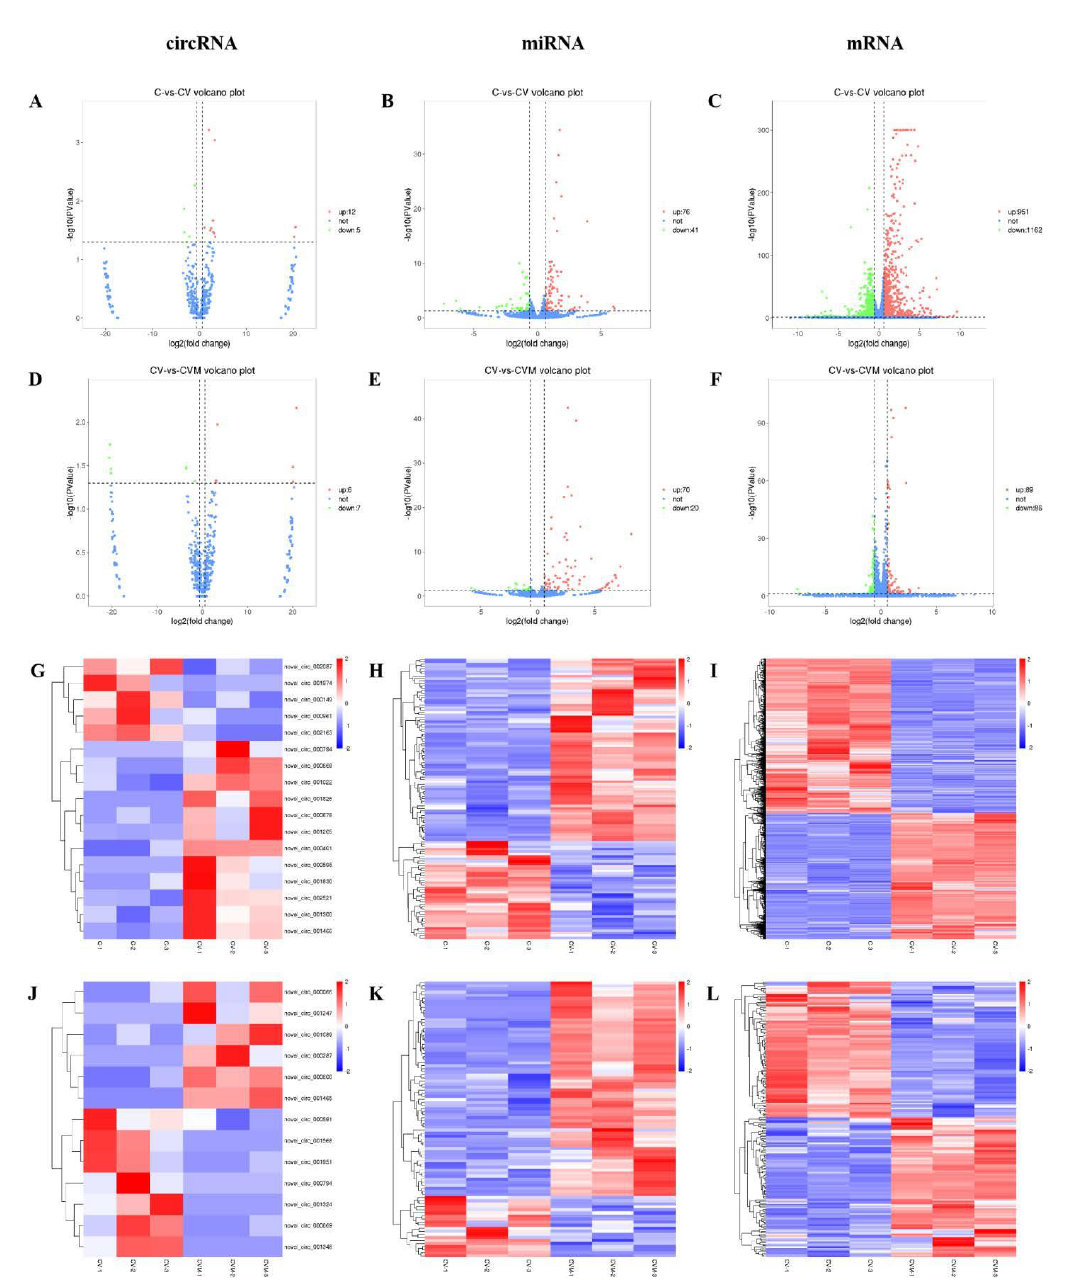
Figure 8. Volcano map and cluster heat map of circRNA, miRNA, and mRNA expression. 17 differentially expressed circRNAs, 117 miRNAs, and 2113 mRNAs between C group and CV group ( A – C ) ( p < 0.05, FC > 1.5). There are 13 differentially expressed circRNAs, 90 miRNAs, and 175 mRNAs between the CV group and the CVM group ( D – F ) ( p < 0.05, FC > 1.5). Heat map generated by hierarchical clustering analysis of differentially expressed circRNA ( G , J ), miRNA ( H , K ), and mRNA ( I , L